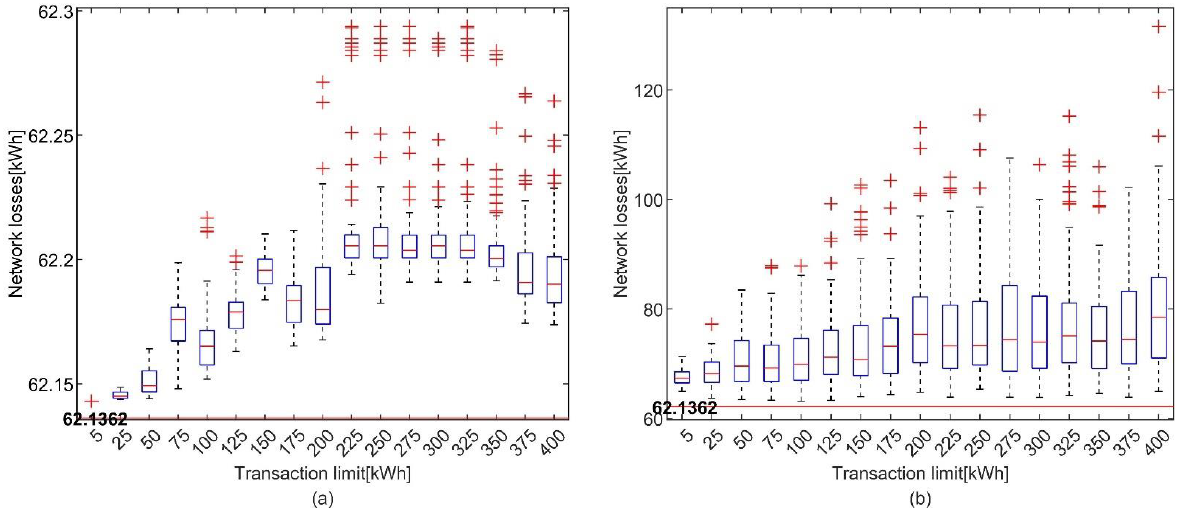
Figure 7. Distribution of network losses in the IEEE 33 bus system: ( a ) the guided case; ( b ) the random case.